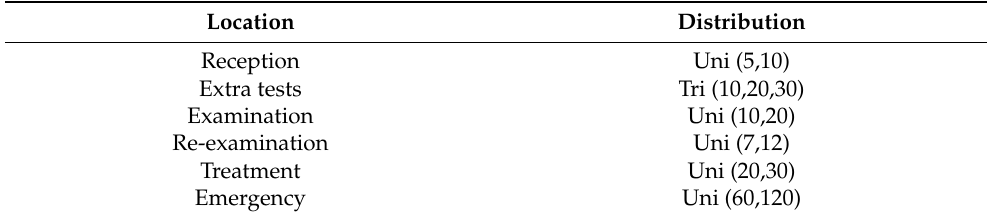
Table 3. Service time